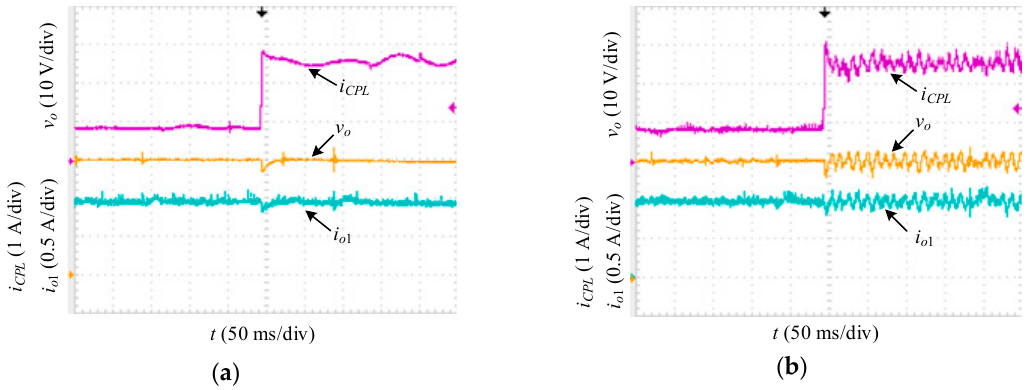
Figure 15. Waveforms of voltage and current of a buck–boost converter with a pure resistive load and a CPL connected in parallel under load disturbances: ( a ) inverse-system decoupling controller; ( b ) conventional double closed-loop controller.